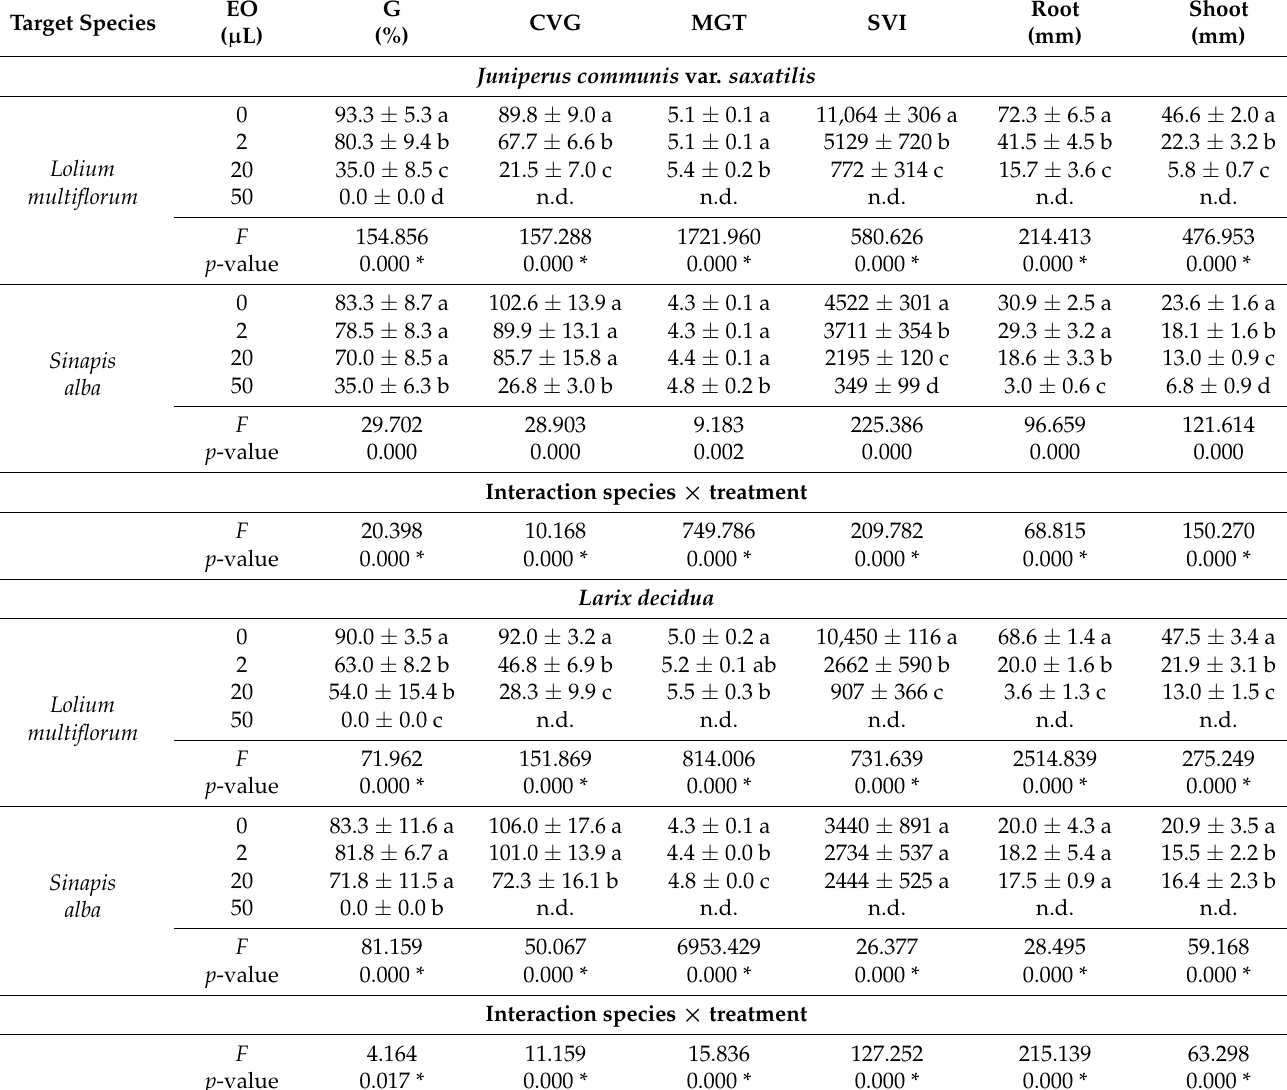
Table 6. Germination and growth values of two target species ( Lolium multiflorum and Sinapis alba ) under the phytotoxic effects of different doses of Juniperus communis var. saxatilis and Larix decidua EOs using filter paper as a